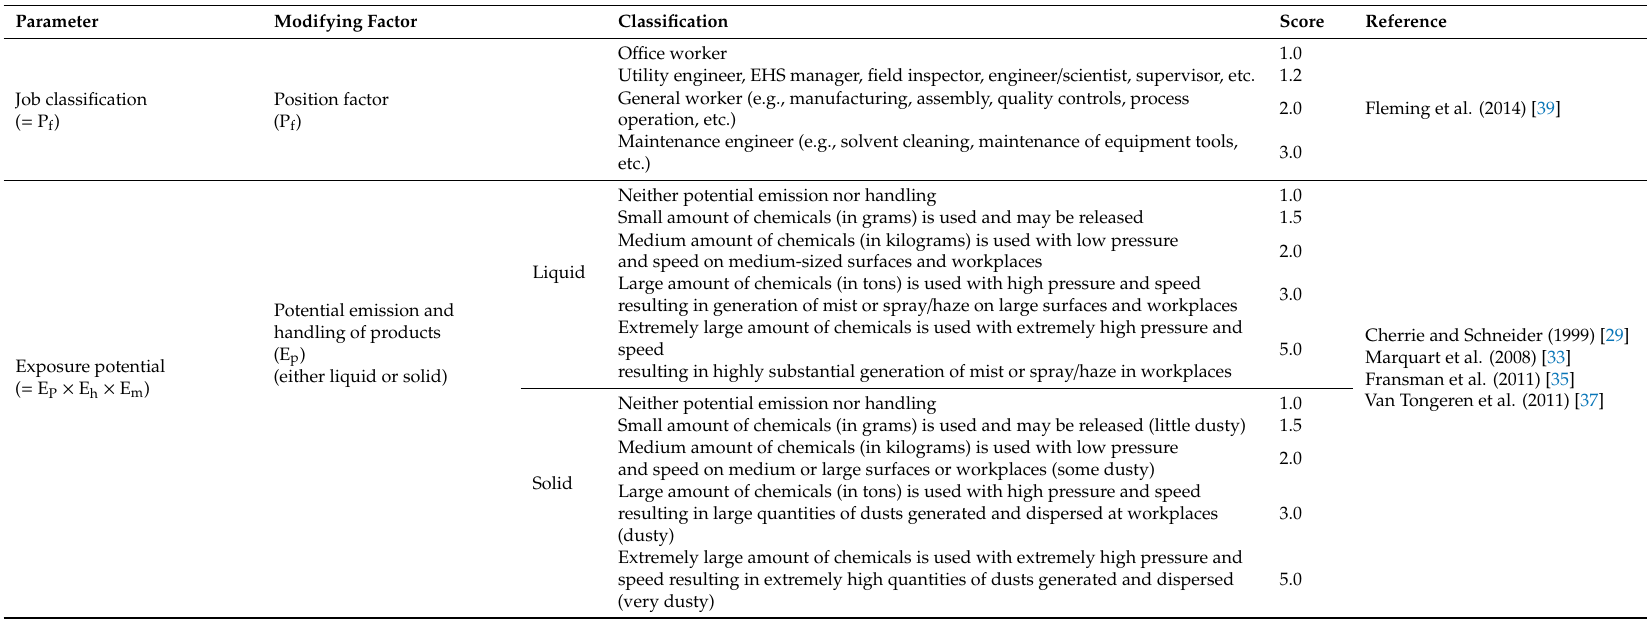
Table 1. A new exposure model for occupational exposure assessment with input parameters, modifying factors, defined classification, and associated